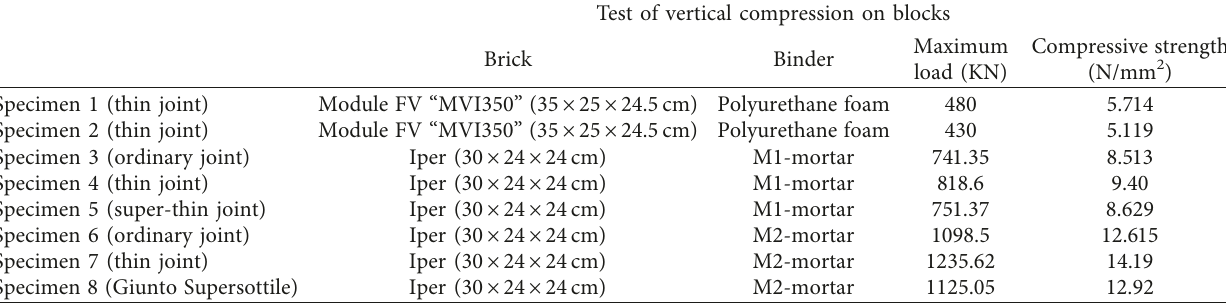
Table 5: Results of vertical compression tests.